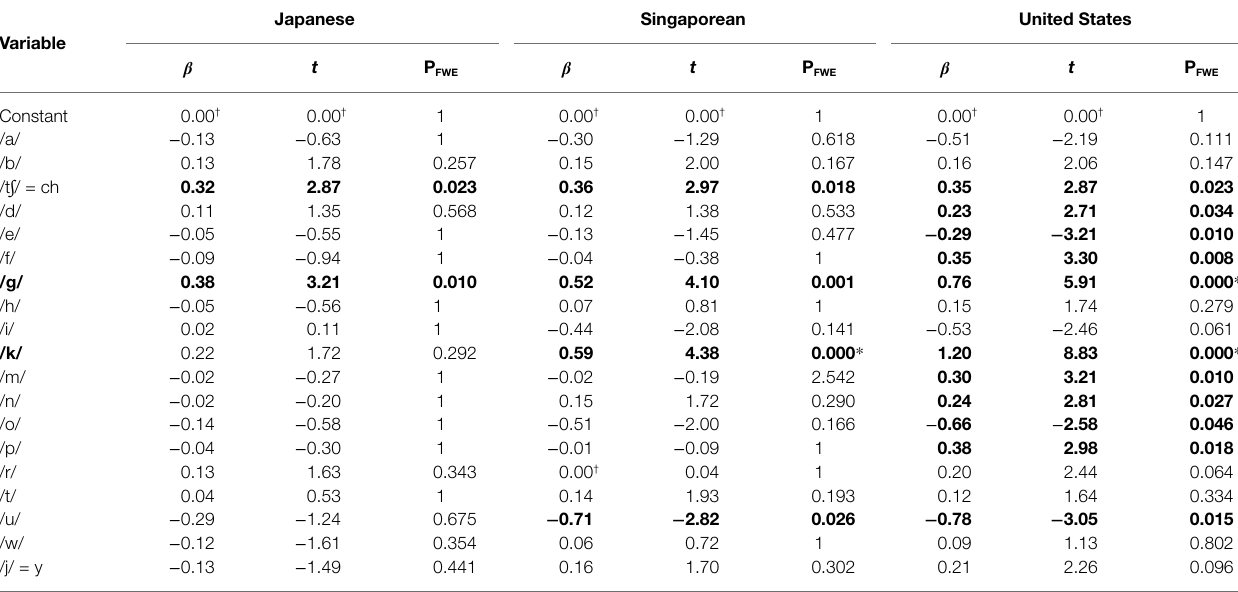
TABLE 3 | Summary of the regression analyses of the three groups.